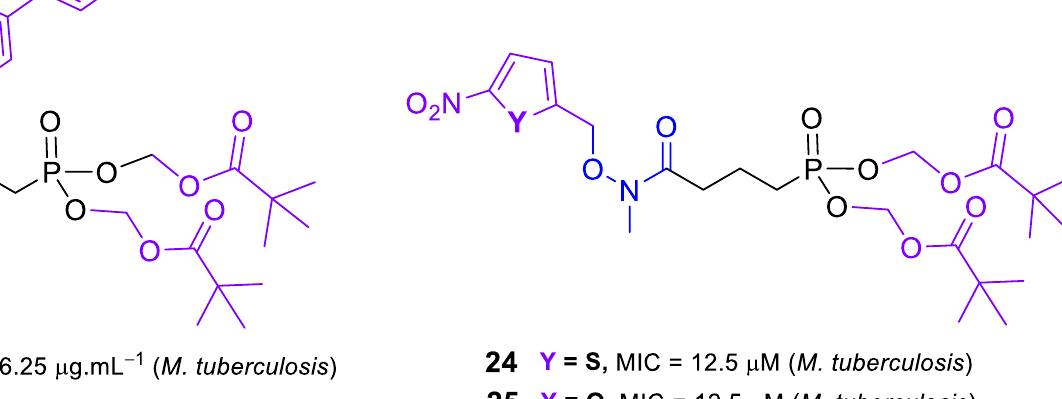
Figure 3. Representative prodrug of fosmidomycin analogs.